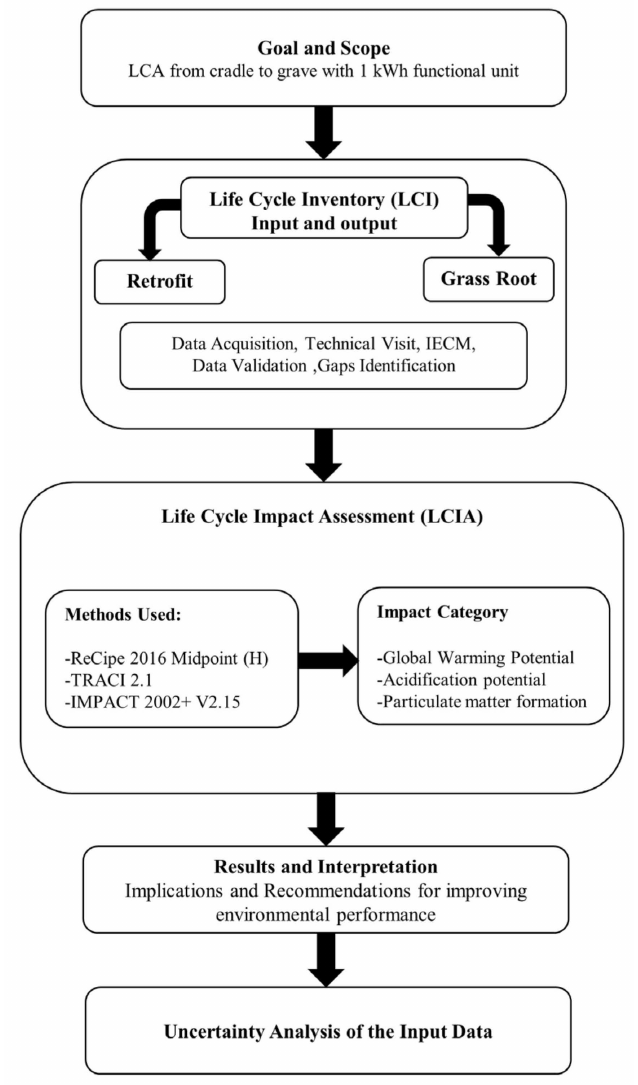
Figure 2. LCA framework employed in this study to evaluate the environmental Impact assessment of NGCC with carbon capture